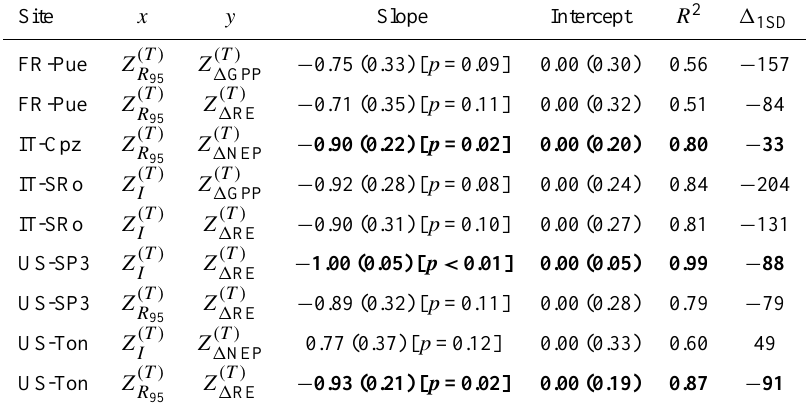
Table 6. Slopes, intercepts (both with standard errors in parentheses and p-value for the slope) and R 2 values for linear regressions between single-site standardised ecosystem flux residuals and precipitation variables, for all regressions with p ≤ 0 . 15. Regressions significant at the 5% level are indicated in bold. Since all values are standardised, all values in the table are unitless, except for column 1 1SD , which shows the change in ecosystem flux (gCm − 2 yr − 1 ) associated with a one standard deviation change in the predictor variable, Z I or Z R Site x y Slope Intercept